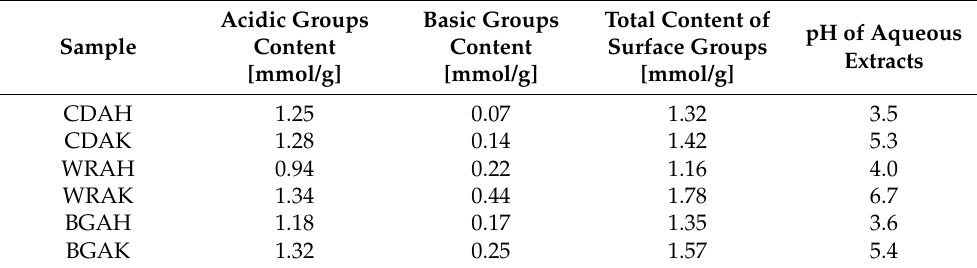
Table 2. Acidic-basic character of the activated carbon